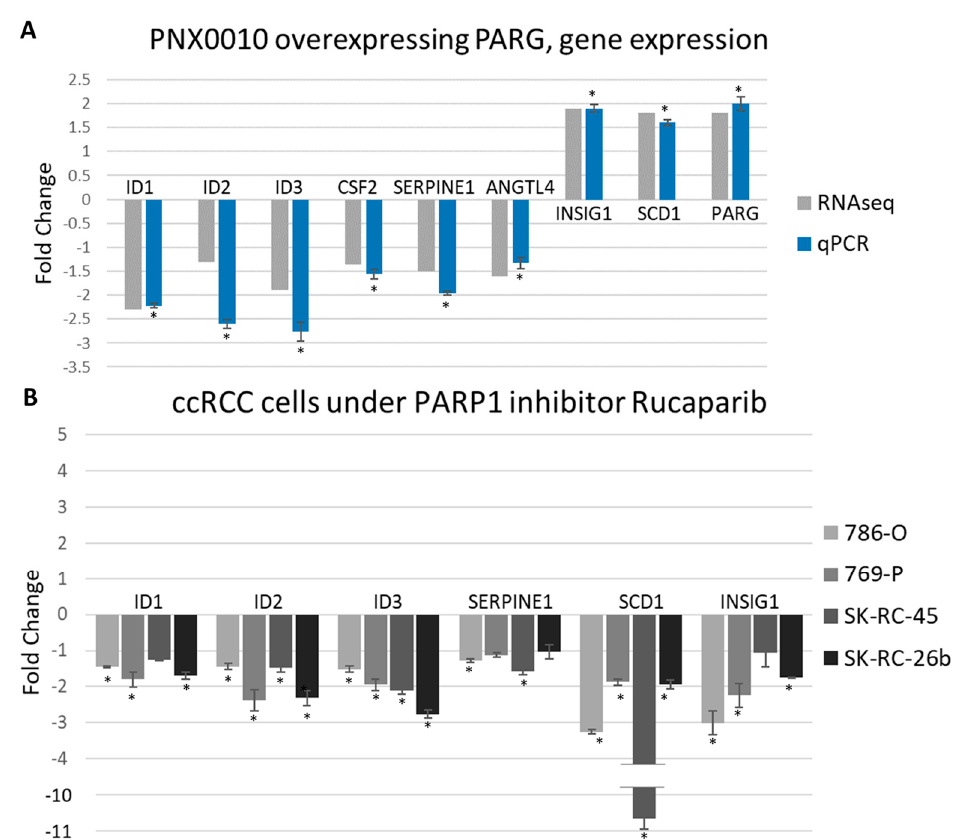
Figure 5. pADPr reduction by PARP-1 inhibition and PARG overexpression affects gene expression in similar way. ( A ) Changes in expression of selected genes measured by qPCR and RNAseq methods in PNX0010 cell line under PARG overexpression. Correspondence of two analyses is demonstrated. * p -value < 0.05 ( B ) qPCR analysis of genes from (A) in ccRCC cell lines under PARP-1 inhibition with 10 uM rucaparib for 24 h. Downregulation of cancer-related genes ID1-ID3 is shown for both PARG overexpression and PARP-1 inhibition. Opposite effect was shown for metabolism-related genes and colony-stimulation factor 2 coding gene. Serpine1 gene shows concordant results under PARP-1 inhibition and PARG overexpression for 786-O and SK-RC-45 cell lines. * p -value < 0.05. Upregulation of lipid biosynthesis genes in PNX0010 cells overexpressing